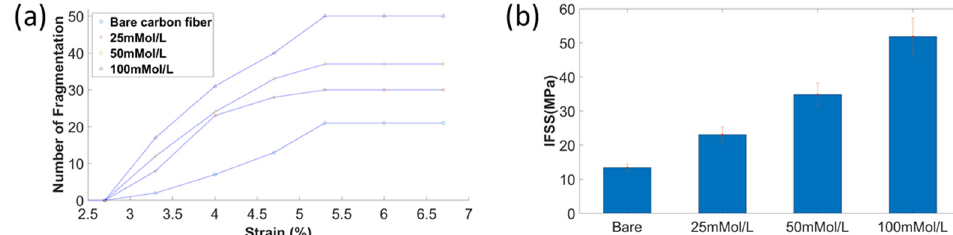
Figure 6. ( a ) number of fragmentations of carbon fiber with and without ZnO nanowires; ( b ) IFSS of carbon fiber without and with ZnO nanowires under different growth concentrations.